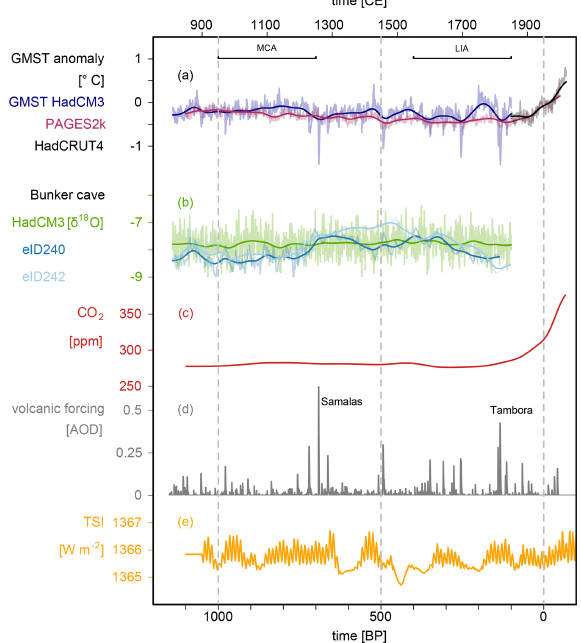
Figure 1. Climate and main climatic drivers over the last millen- nium. (a) Global annual mean surface temperature (GMST) as mod- eled (iHadCM3, blue), reconstructed (PAGES2k, red) (PAGES2k- Consortium, 2019), and observed (HadCRUT4, black) (Morice et al., 2012). (b) Annual mean δ 18 O in precipitation at Bunker Cave, Germany, as modeled (iHadCM3, green) and measured cal- cite δ 18 O (drip water equivalent) from SISAL entity 240 (dark blue) and 242 (light blue) at the Bunker cave site (Comas-Bru et al., 2019; Fohlmeister et al., 2012). Comparison plots for all entities are given in Figs. S1–S2 in the Supplement. (c) Atmospheric CO 2 concentra- tion, (d) volcanic forcing in units of aerosol optical depth (AOD) (Crowley and Unterman, 2013), and (e) total solar irradiance (TSI) as used in the model simulations (Steinhilber et al., 2009; Wang et al.,